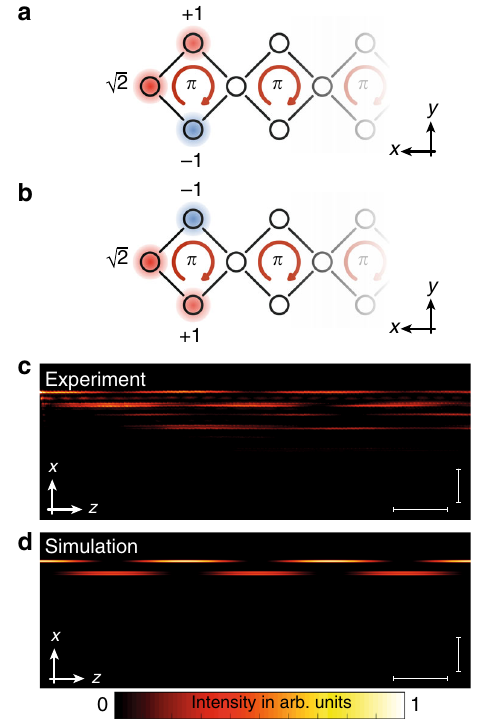
ffiffiffi p t . b Amplitude 2 ffiffiffi p t . c Beating pattern 2